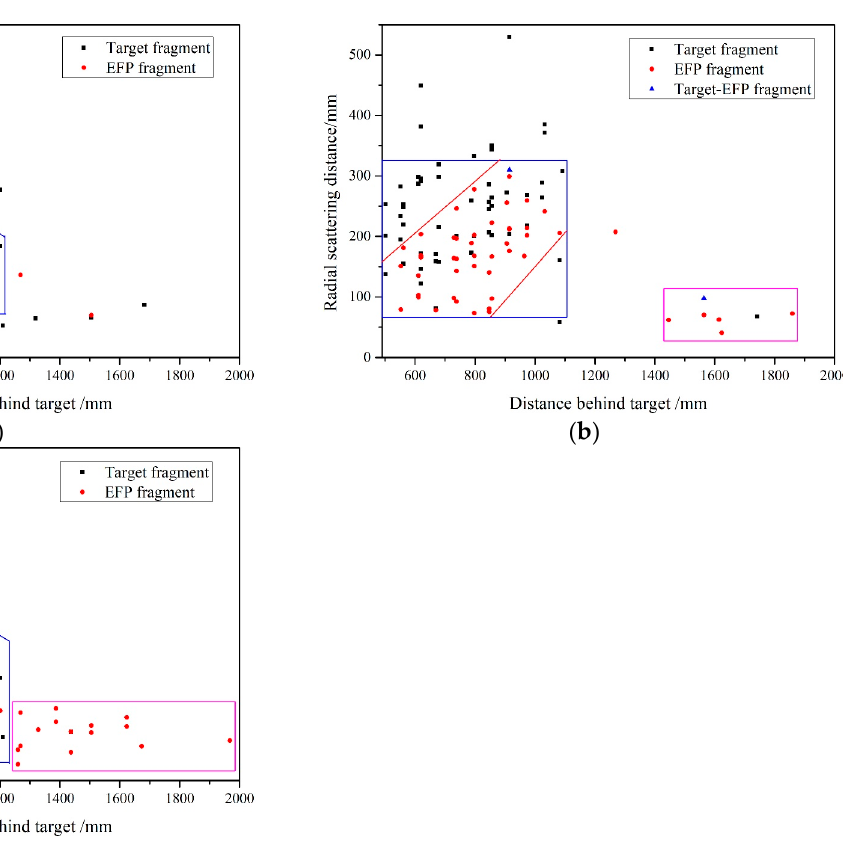
Figure 8. Two-dimensional projection of the striking area on the XZ plane. ( a ) L / D = 1.66 ( b ) L / D = 2.4 ( c ) L / D = 3.86.